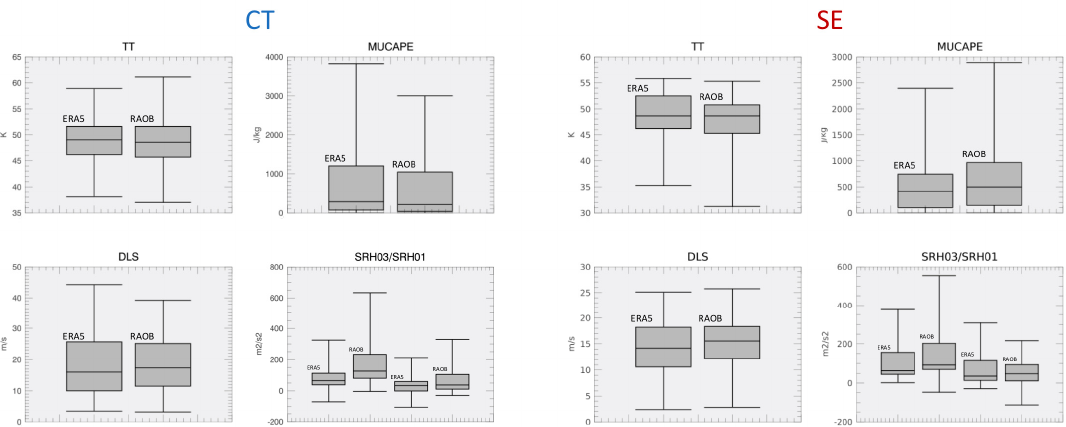
Figure A2. Box − and − whiskers plots for TT, MUCAPE, DLS, and SRH03/SRH01, both for CT and SE.